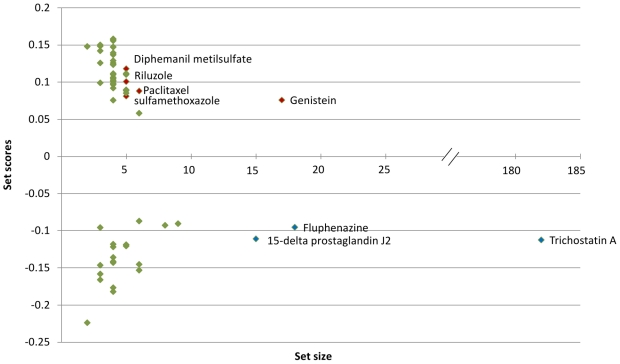
setscore-vs-setsize plot of significant connections to the cervical cancer signature.Green- significant connections; Blue- significant negative connection setscores with high PS and large setszie; Red- significant positive connection setscores with high PS and large setsize.